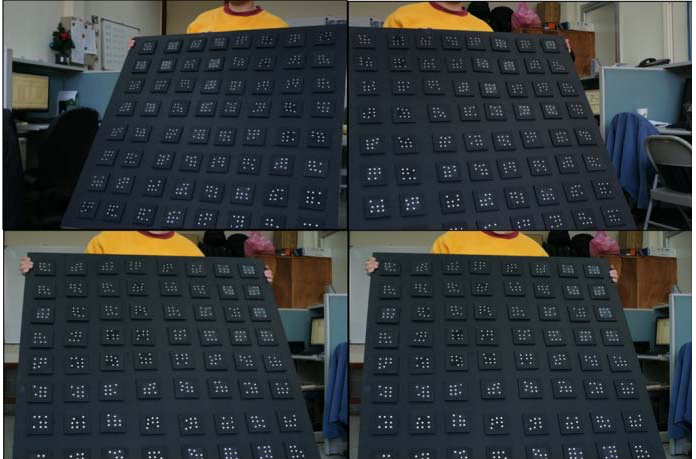
Figure 15. Four calibration image samples from the 1 × 5